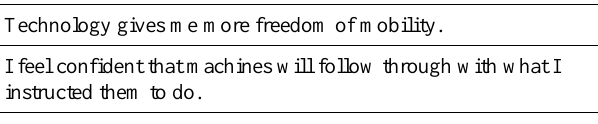
Figure 1: Mean scores of men’s and women’s levels of technophobia towards three different technology